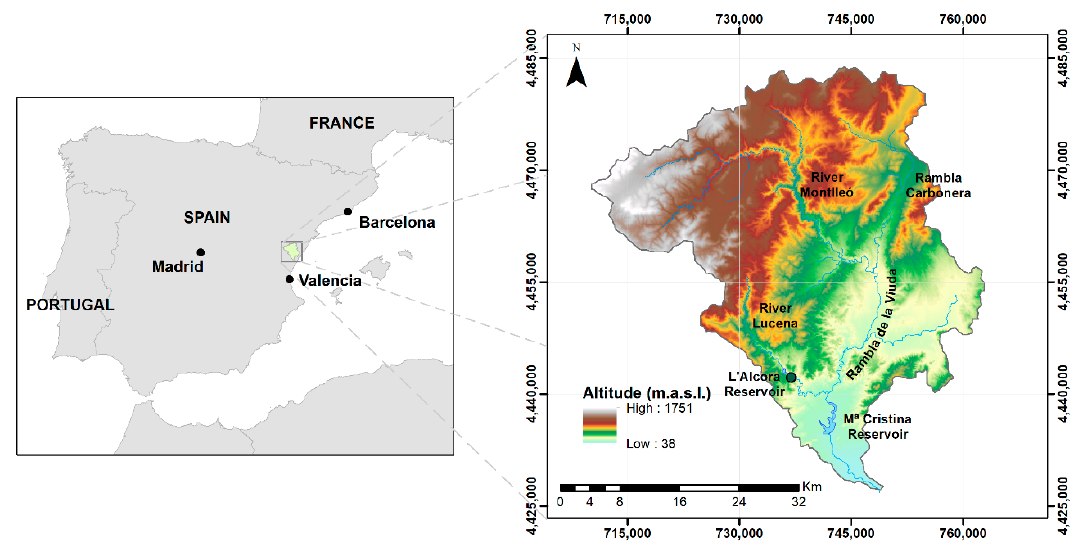
Figure 1. Study area: Rambla de la Viuda catchment.